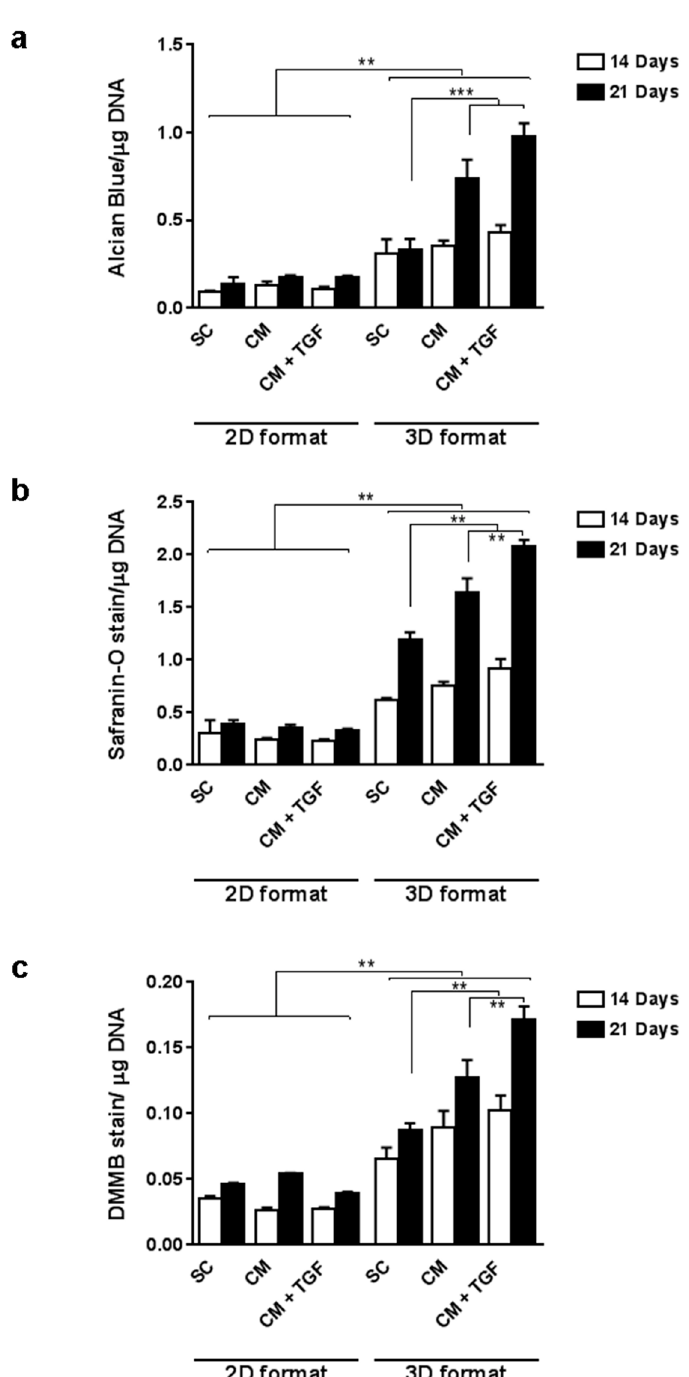
Figure 3. MSC chondrogenic response in 2D monolayer culture and 3D micropellet culture assessed by Alcian Blue assay ( a , n = 4), Safranin-O assay ( b , n = 4) and DMMB assay ( c , n = 8). Error bars represent the standard error of the mean. ** p < 0.01, *** p < 0.001. SC: standard culture medium, CM: chondrogenic differentiation medium, CM + TGF: chondrogenic medium supplemented with TGF- β 1.